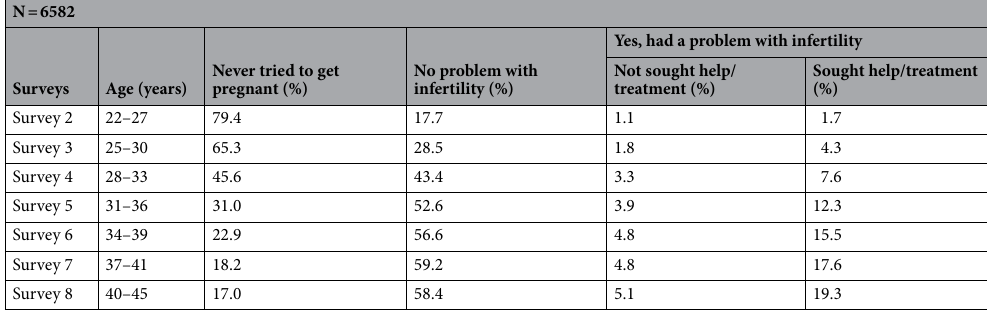
Table 1. Proportion of women’ ever’ reporting presence or absence of infertility from Survey 2 to survey 8. Table shows the percentages from the original variable from the survey. The question asked was “Have you and your partner (current or previous) ever had problems with fertility—that is, tried unsuccessfully for 12 months or more to get